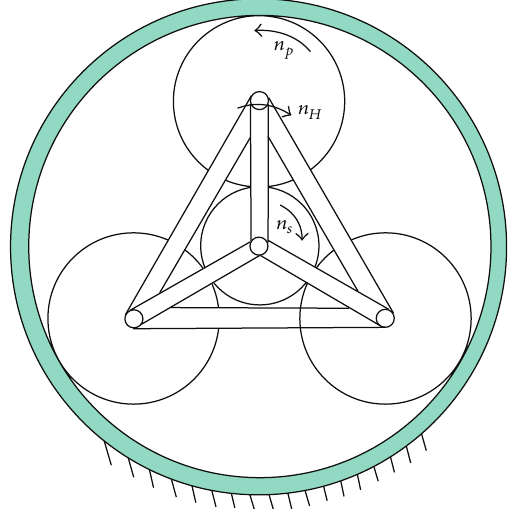
Figure 1: A schematic graph of planetary gear